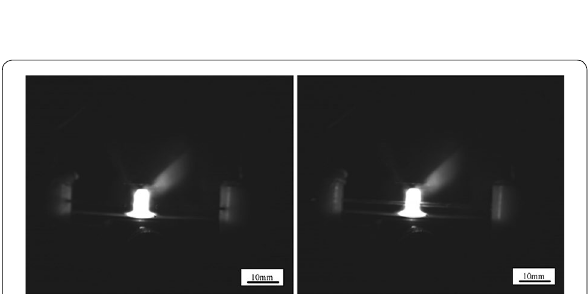
Figure 6 State of the probes before they rotate into the plasma arc and state of the probes within the plasma